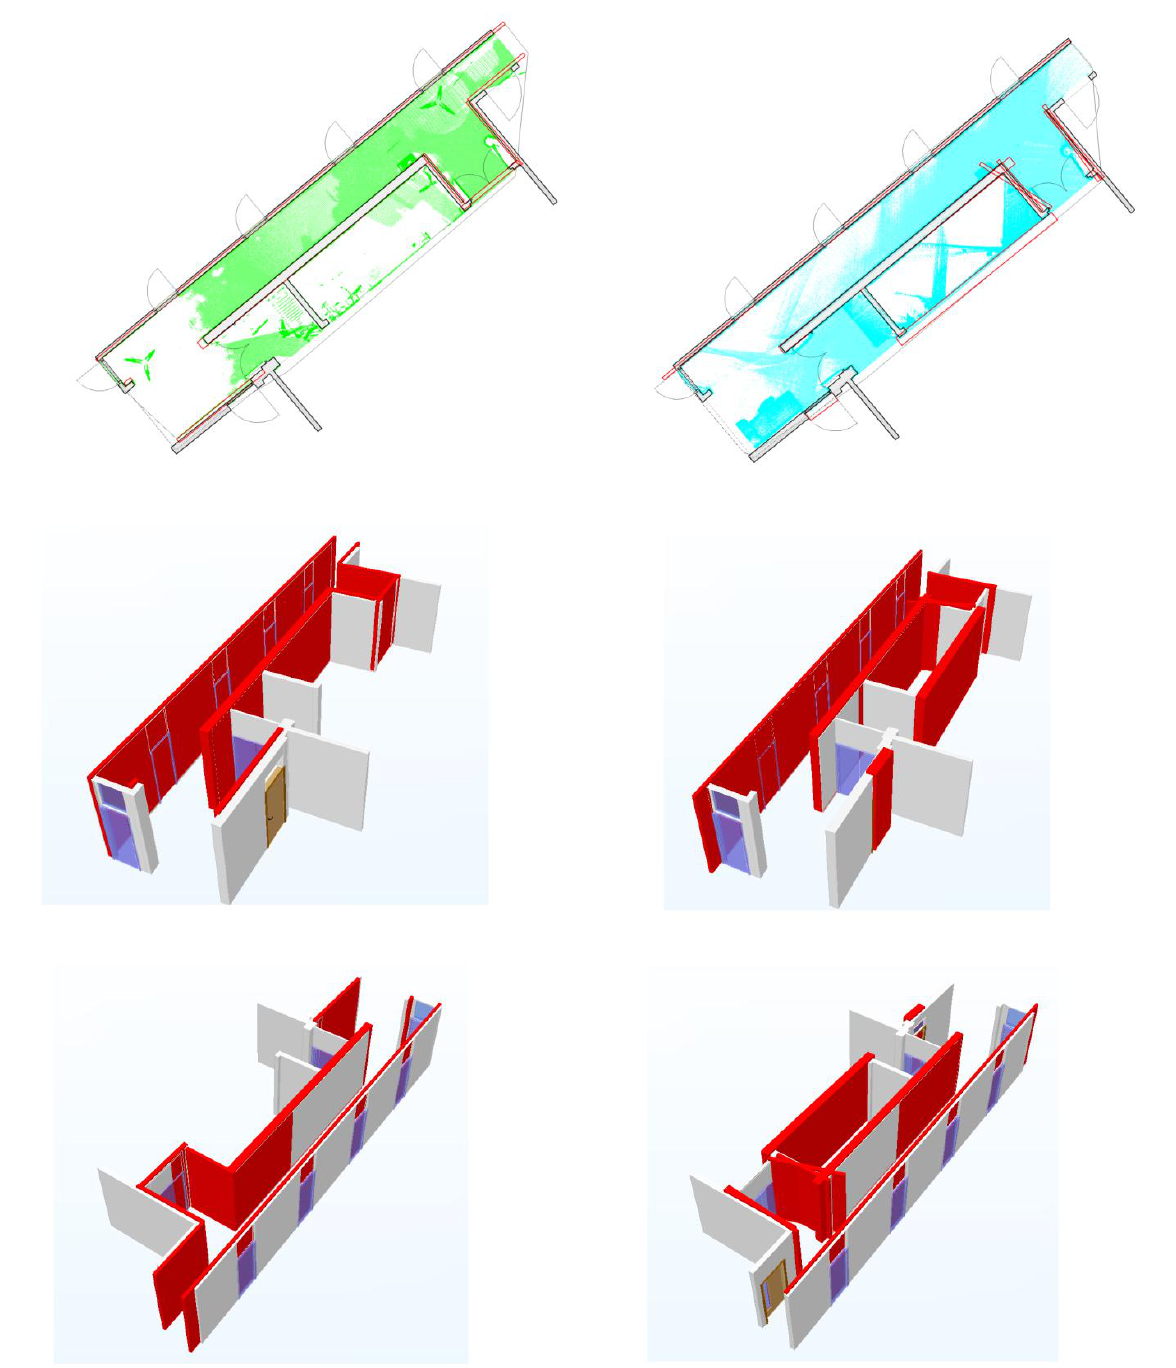
Figure 8. Extracted walls (red) of the corridor from the static (green) and mobile (blue) point cloud data overlaid on the human-generated model